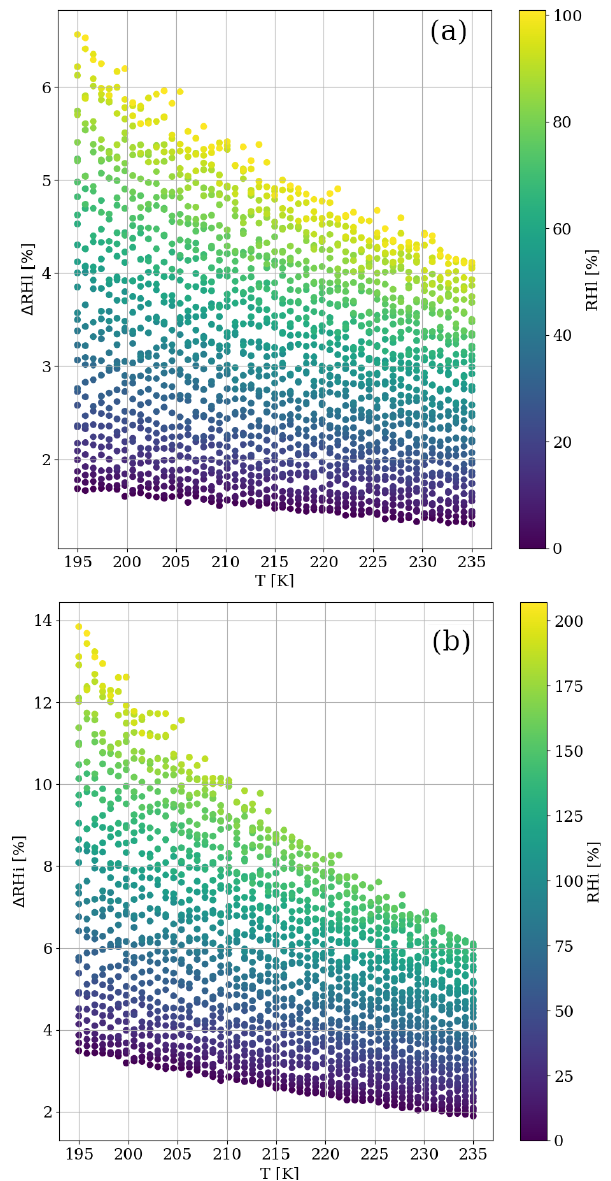
Figure A1. Uncertainty in the RHl (a) and RHi (b) estimations as a function of temperature ( x axis) and RHl and RHi (colour shading),